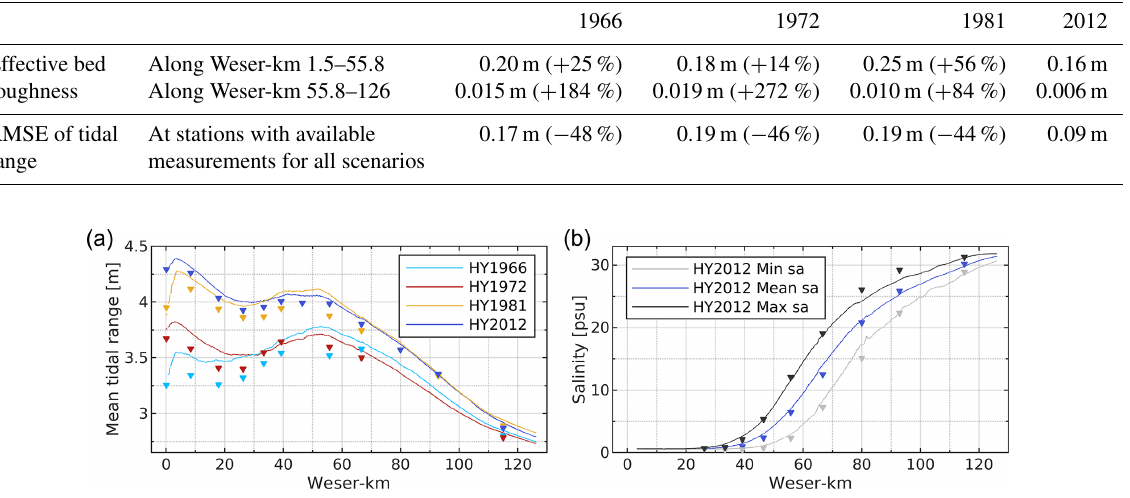
Figure 3. Mean tidal range along the navigation channel of the Weser estuary (see Fig. 1) in hindcast models of 2012, 1981, 1972, and 1966 (a) and vertically averaged mean, minimum, and maximum salinity per tide (average) in hindcast model HY2012 (b) . Simulation results (lines) are compared with measured values (triangles), averaged over the same